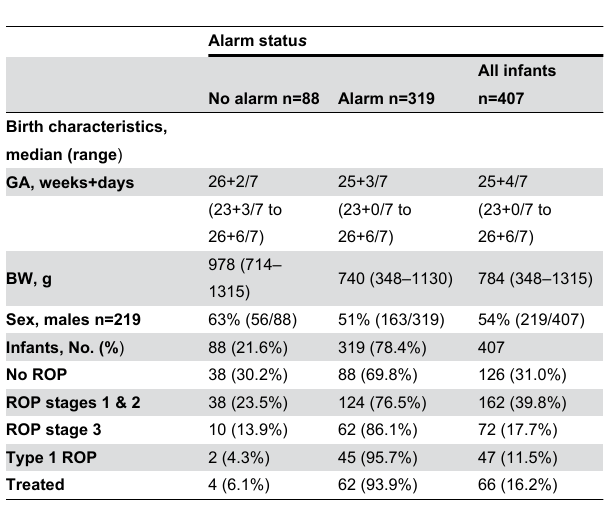
Table 1. Alarm Signal in Relation to ROP Categories and Birth Characteristics.